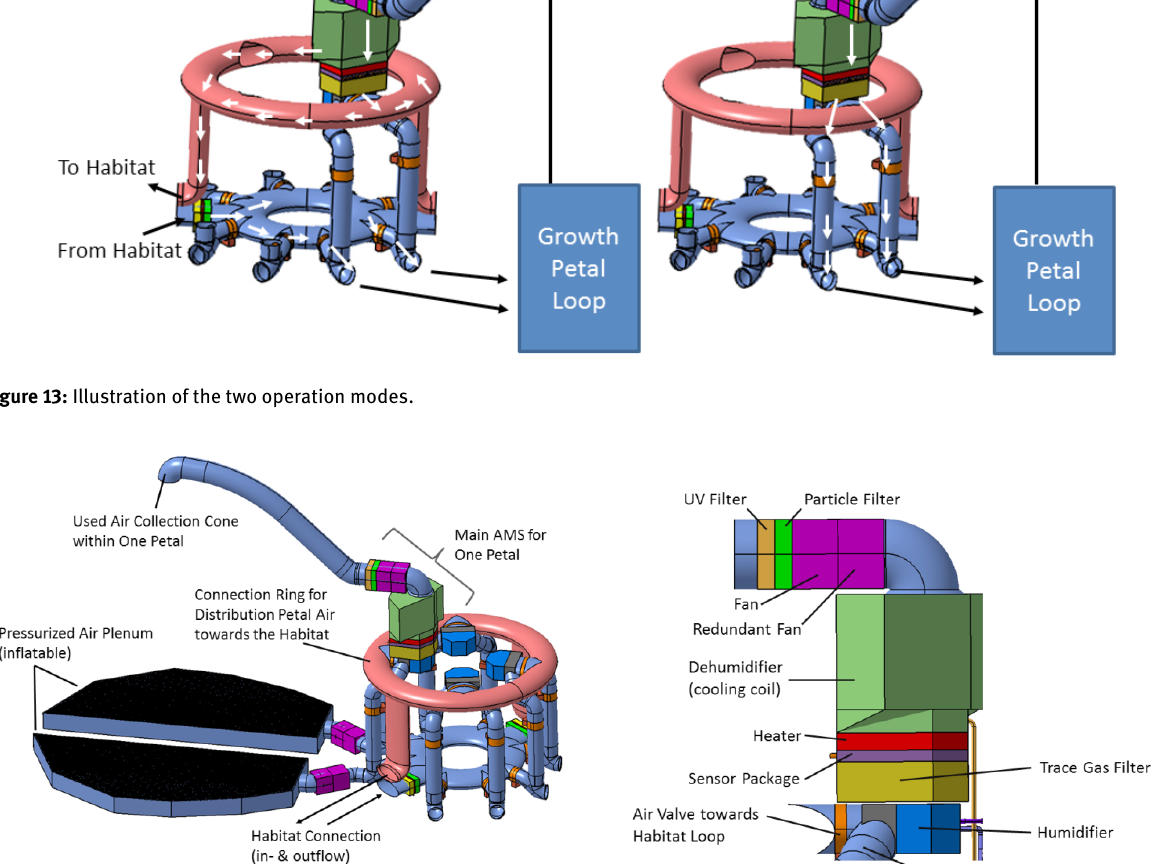
Figure 14: Illustration of the main AMS